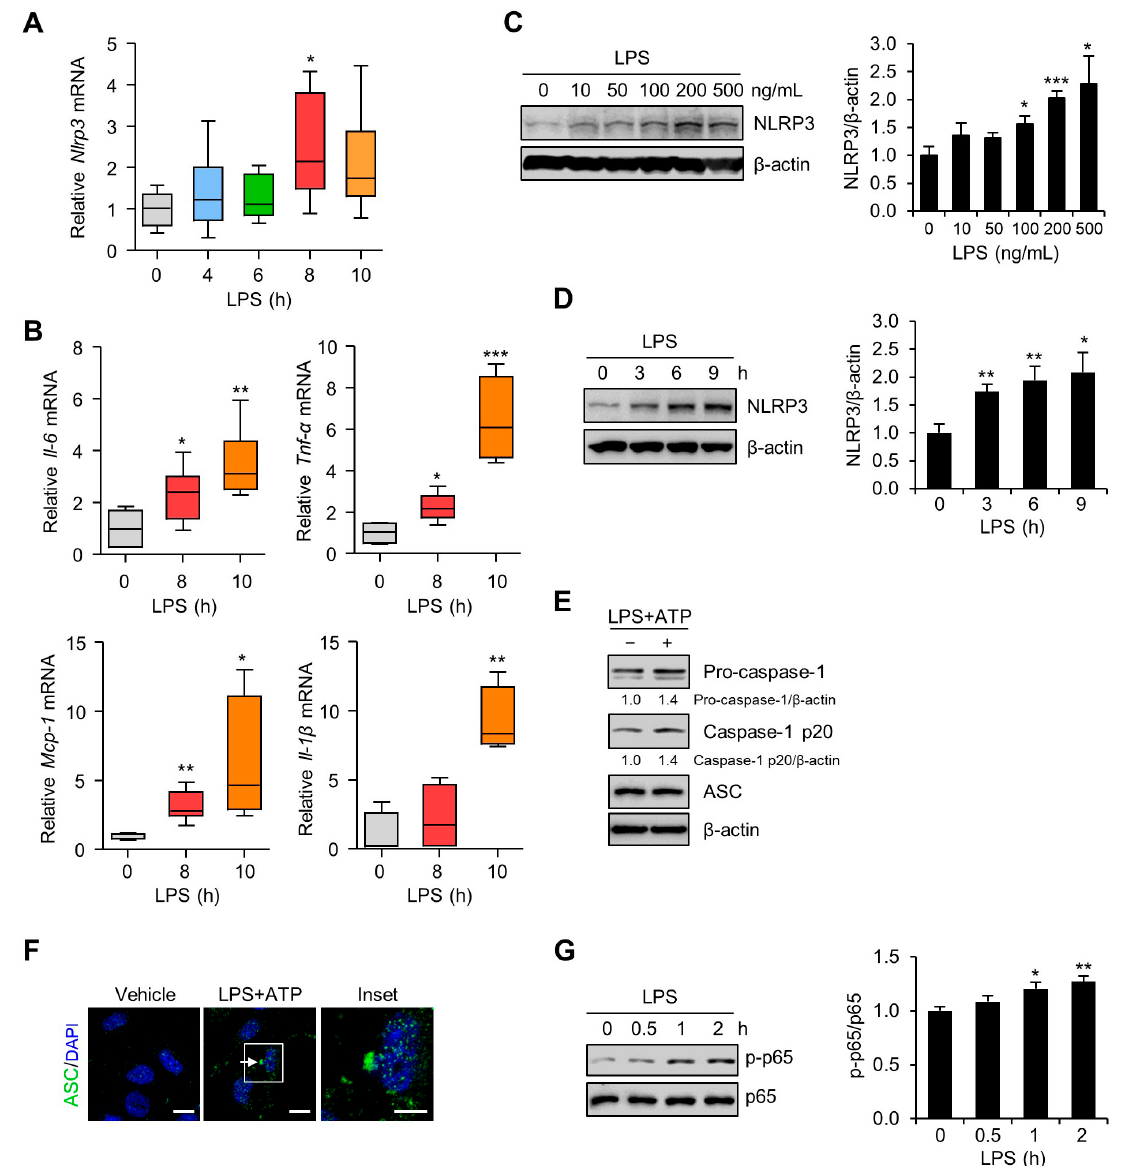
Figure 2. NLRP3 inflammasome activation in placentas of mice and in human trophoblasts exposed to LPS. ( A , B ) C57BL / 6 pregnant mice were injected intraperitoneally with LPS (100 µ g / kg) on gestation day 17.5. After the indicated number of hours, placentas were harvested and analyzed using real-time PCR for the expression of NLRP3, IL-6, TNF- α , MCP-1, and IL-1 β ( n = 4–7). ( C ) Sw.71 cells were treated with the indicated concentration of LPS for 4 h. Cell lysates were immunoblotted with an anti-NLRP3 antibody. ( D , G ) Sw.71 cells were treated with 200 ng / mL LPS for the indicated time periods. Cell lysates were immunoblotted with anti-NLRP3 ( D ) and anti-p-p65 NF- κ B, and anti-p65 NF- κ B ( G ) antibodies. ( E ) Sw.71 cells were treated with LPS (100 ng / mL) for 24 h and then followed by ATP (5 mM) treatment for 45 min, or were treated with vehicle. Cell lysates were immunoblotted with anti-caspase-1 and anti-ASC (apoptosis-associated speck-like protein) antibodies. β -Actin or p65 served as a loading control. Band intensities were quantified and normalized over the β -actin or p65 values. ( F ) Immunofluorescence staining of ASC (green) in Sw.71 cells treated with LPS (100 ng / mL) for 24 h and then followed by ATP (5 mM) treatment for 45 min, or treated with vehicle. The white arrow represents ASC specks. Nuclei were stained with DAPI (blue). Scale bars, 20 µ m; inset, 10 µ m. Data are shown as mean ± SEM. Results are representative of at least three independent experiments. * p < 0.05; ** p < 0.01; *** p < 0.001 (Student’s t -test).